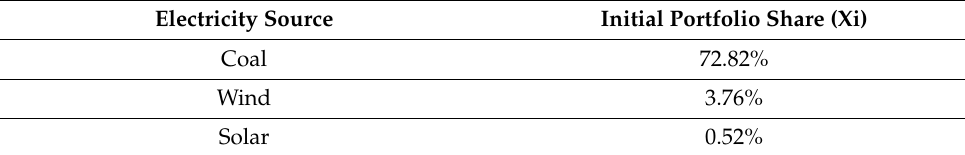
Table 4. Initial Model Configuration.